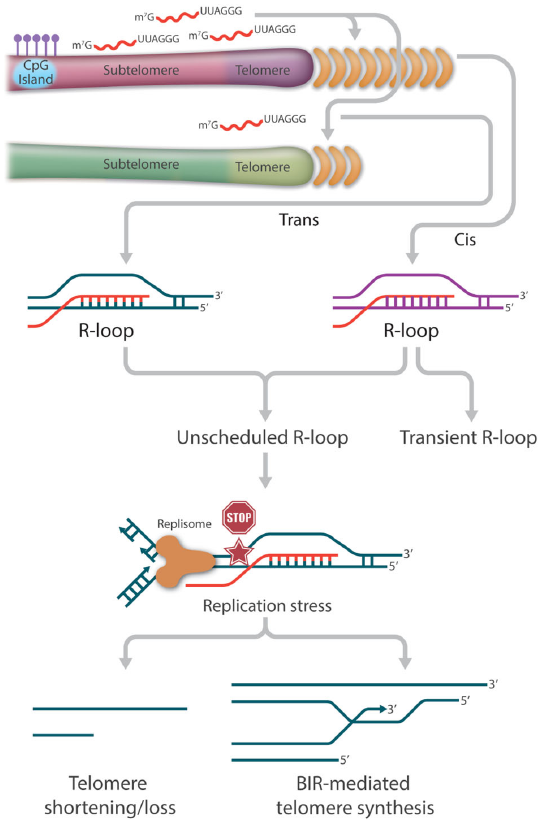
Figure 2. The role of TERRA-mediated R-loops in telomere length regulation. TERRA-mediated R-loop association with telomers could occur in cis and in trans. In general, telomeric R-loops are formed transiently and resolved rapidly to minimize the risk of transcription-replication collisions and thus have no detrimental effect on telomere integrity. However, the loss of balanced telomeric R-loop formation and resolution results in the accumulation of persistent or unscheduled R-loops at telomeres, which becomes one of the major drivers of replication stress. In the absence of a functional repair pathway, fork collapse and double strand breaks (DSB) can lead to telomere attrition. In the presence of a functional HR pathway, fork collapse and double strand breaks (DSB) can initiate break-induced replication (BIR)-mediated telomere synthesis.